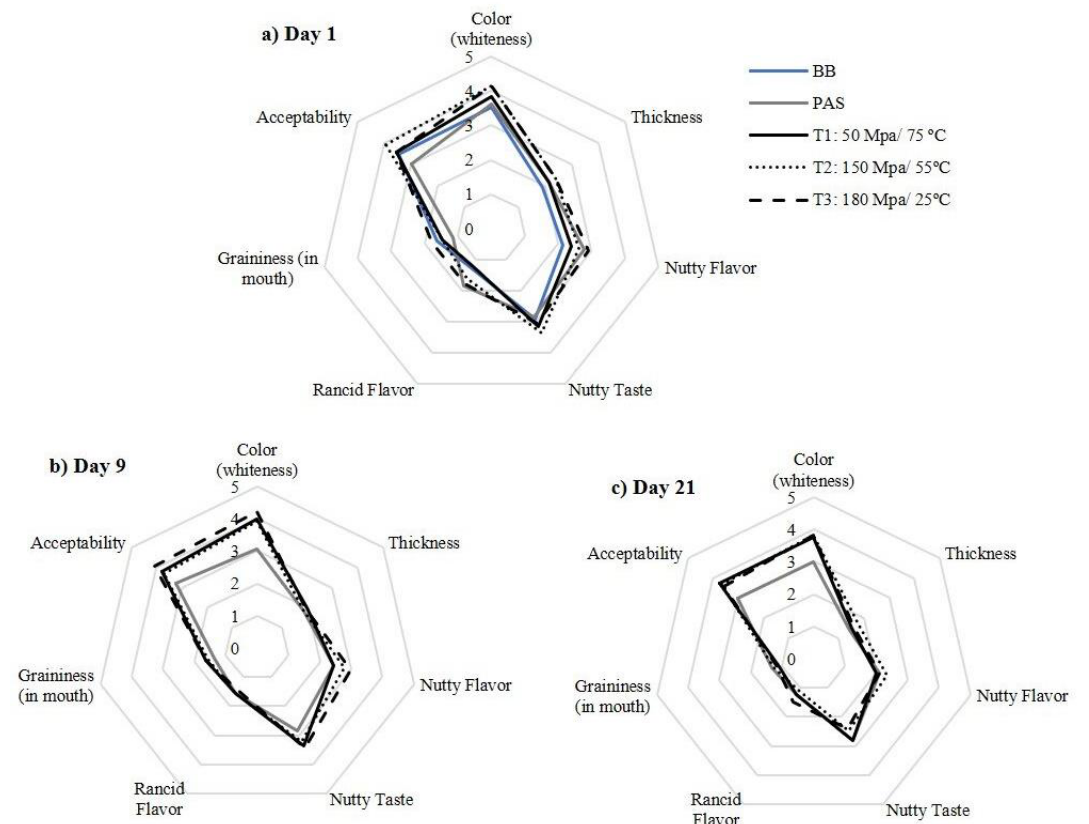
Figure 6. Sensorial control of the Brazil nut beverage (BNB) treated with high-pressure homogeni- zation (HPH) and pasteurization (PAS) and stored at 5 °C for 21 days. tion (HPH) and pasteurization (PAS) and stored at 5 ◦ C for 21